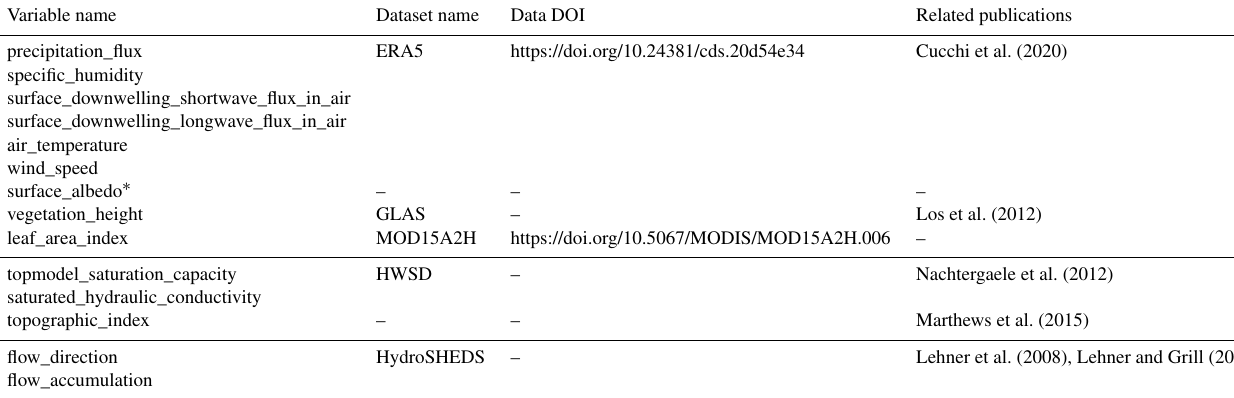
Table A1. Sources for data used in configuration 1.